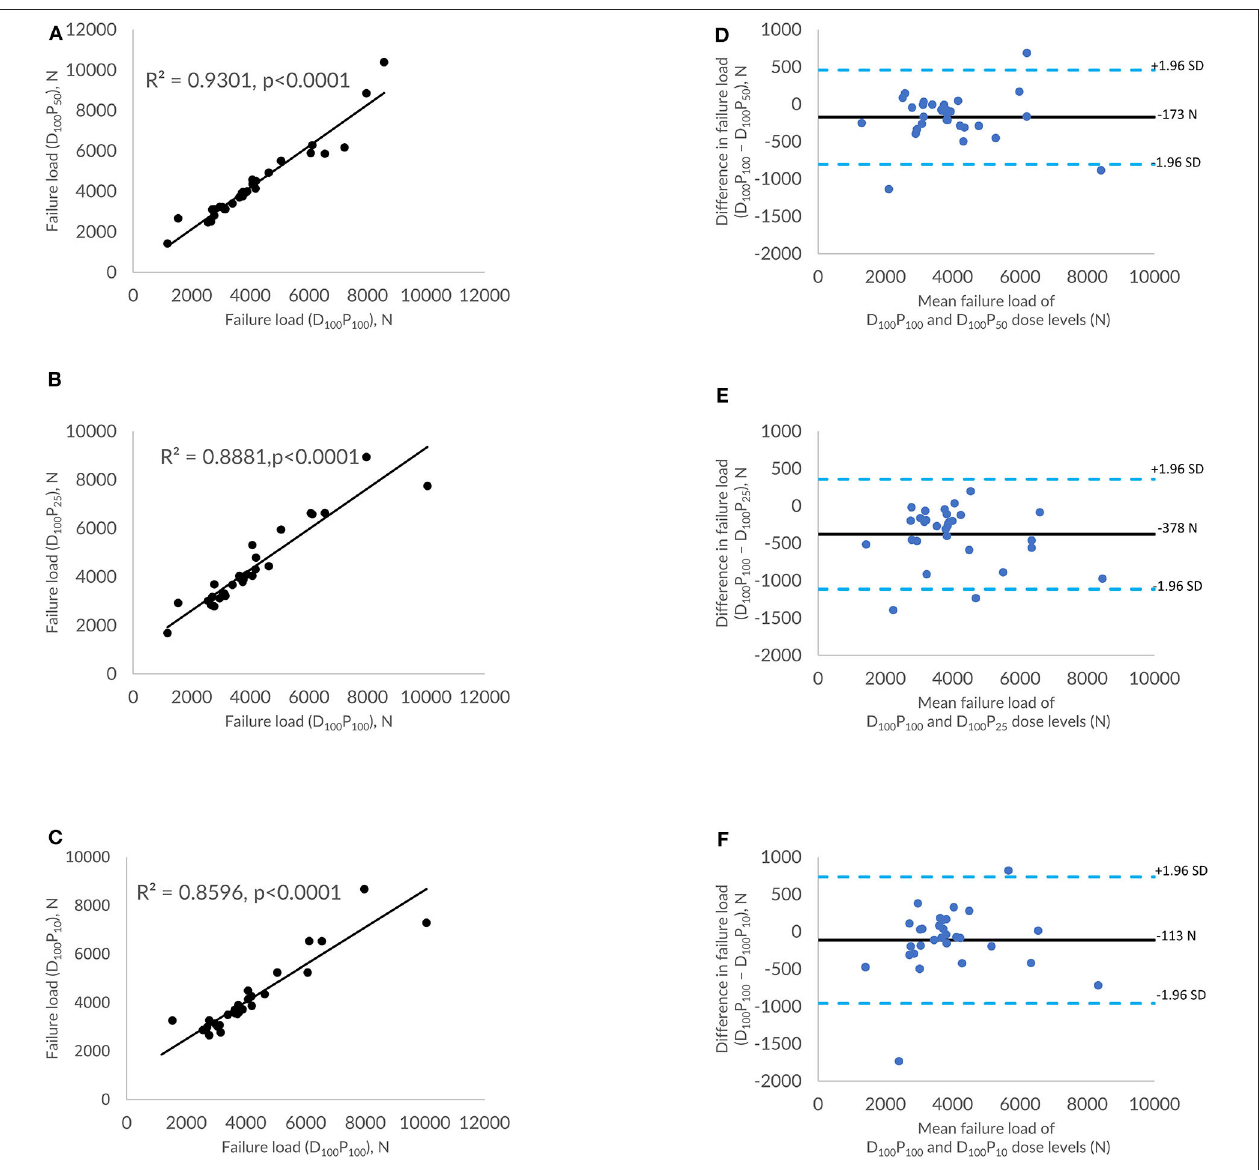
FIGURE 3 | Effect of dose reduction through sparse sampling on FE-predicted failure load values. (A) Correlation plot between FE-predicted failure load values of original dose (100%) and 50% reduced dose, (B) correlation plot between FE-predicted failure load values of original dose (100%) and 75% reduced dose, (C) correlation plot between FE-predicted failure load values of original dose (100%) and 90% reduced dose, and (D–F) Bland-Altman plots representing the mean of FE-predicted failure load values vs. the difference between them. Horizontal lines represent mean and dashed line ± 1.96 standard deviation. FL represents FE-predicted vertebral failure load